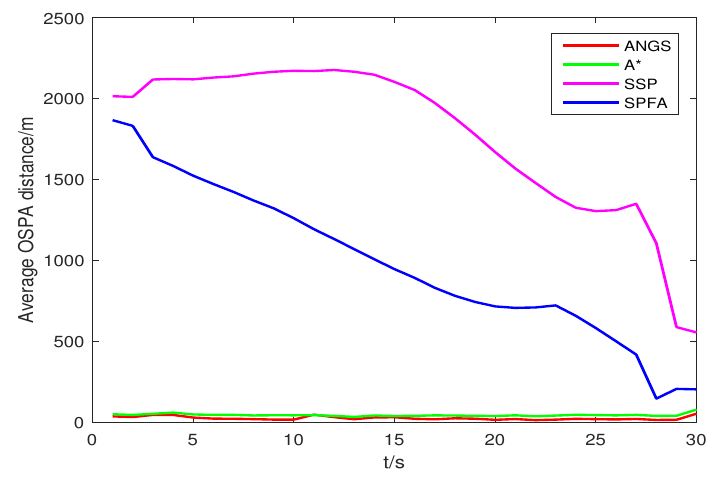
Figure 5. The average OSPA distance in scenario 1, with c = 10 and p = 2.